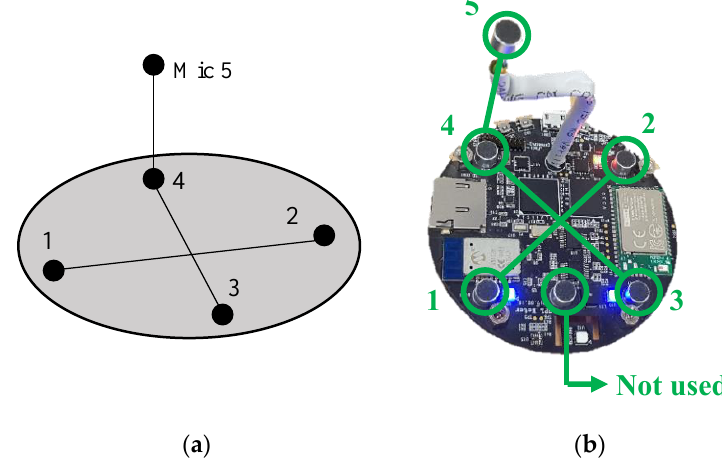
Figure 7. Pairing of the microphones on the sensor board: ( a ) simplified microphone array structure and ( b ) actual hardware system.